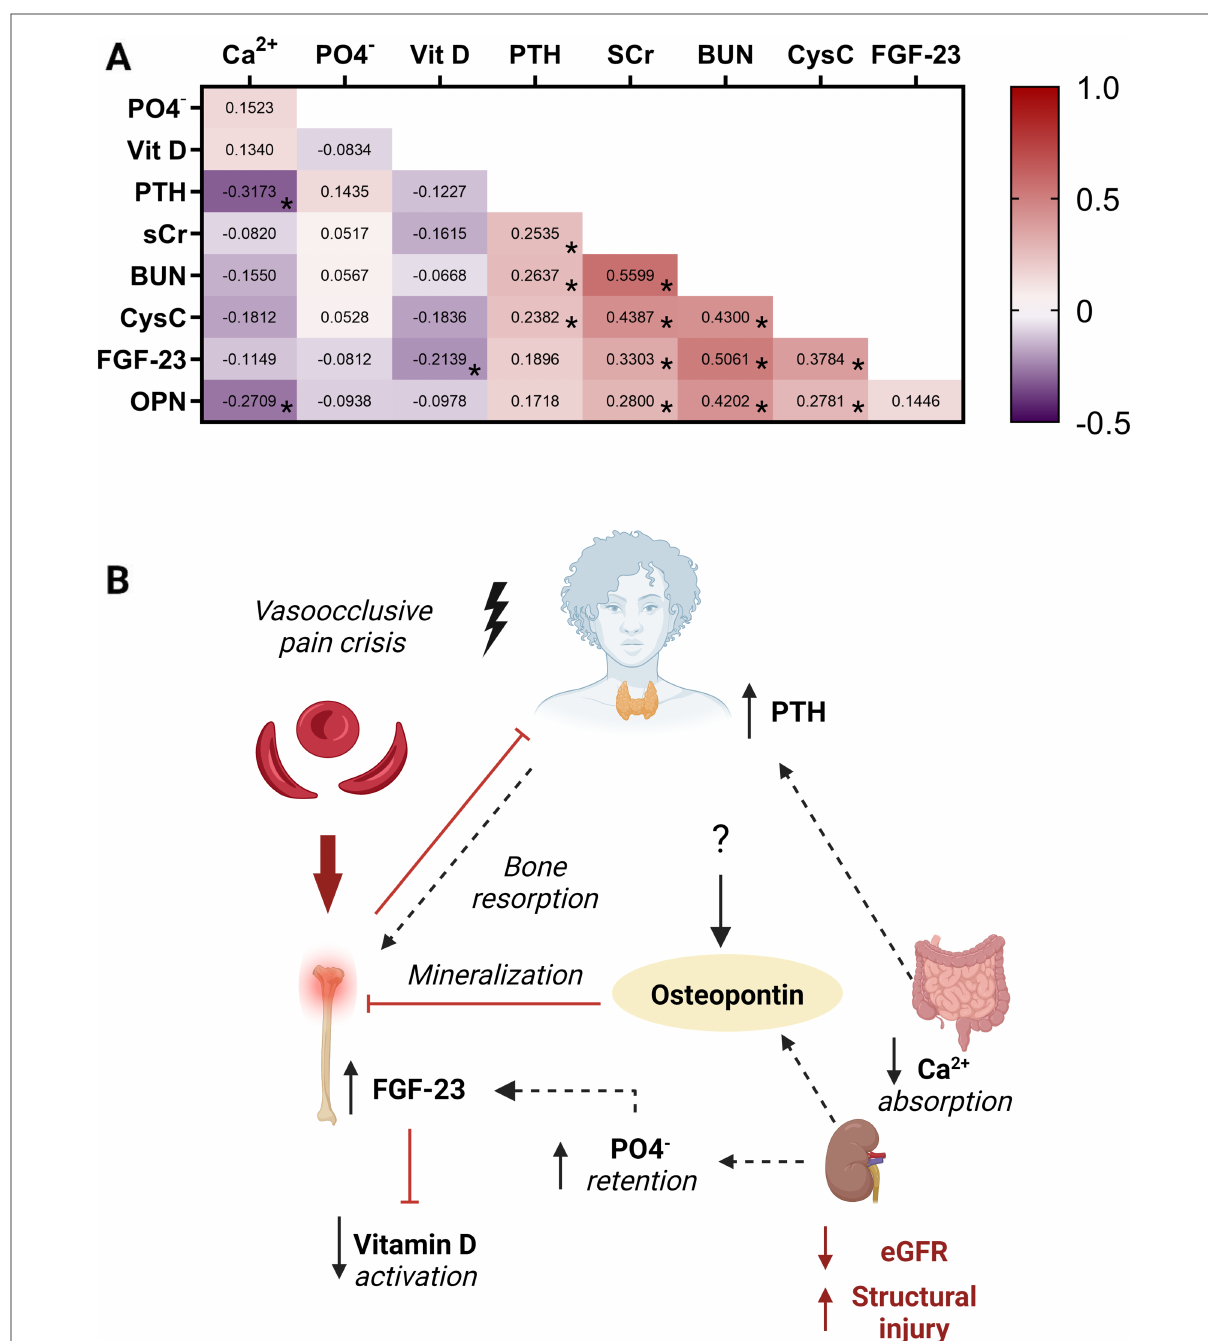
FIGURE 6 The bone-kidney axis during a vaso-occlusive event. ( A ) Heatmap depicting the Spearman correlation coef fi cients between serum measures of mineral metabolism and kidney function. Positive relationships are depicted in red while negative relationships are shown in purple. Relationships signi fi cant following adjustment for multiple testing are indicated with an asterisk based on an adjusted alpha of 0.005. ( B ) Conceptual diagram depicting the relationship between measures of bone mineral metabolism and kidney function during a vaso-occlusive crisis demonstrating the relationship depicted in the heatmap. Low serum calcium levels and increased phosphate levels lead to hyperparathyroidism with resultant bone resorption. The high phosphate levels due to reduced kidney clearance led to high FGF23 which is known to inhibit vitamin D activation. Osteopontin released by various cells and upregulated in AKI, inhibits bone mineralization. Abbreviations: calcium (Ca 2+ ), phosphate (PO4 − ), Vitamin D (Vit D), parathyroid hormone (PTH), serum creatinine (SCr), blood urea nitrogen (BUN), Cystatin C (CysC), fi broblast growth factor 23 (FGF23), Osteopontin (OPN). Created with